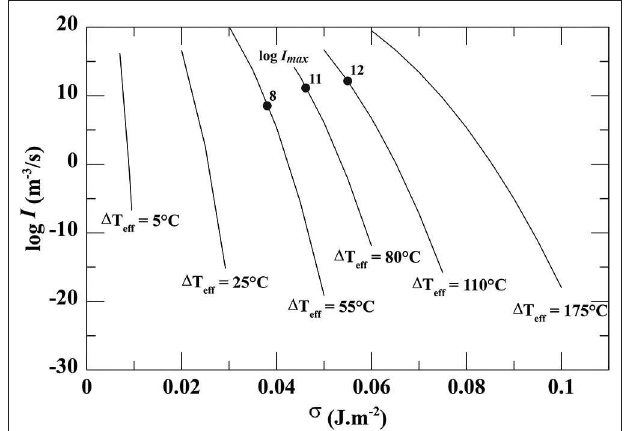
FIGURE 2 | Dependence of the nucleation rate ( I ) on the interfacial energy ( σ ) as a function of effective undercooling ( 1 T eff ), calculated from the Classical Nucleation Theory. The black dots show the empirical I max determined from the crystallization experiments of Mollard et al.